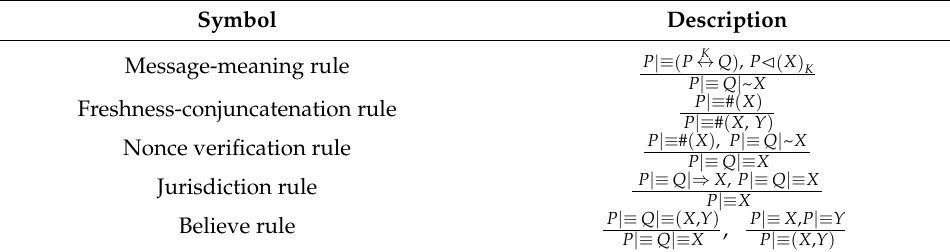
Table 5. Basic logical postulates of BAN